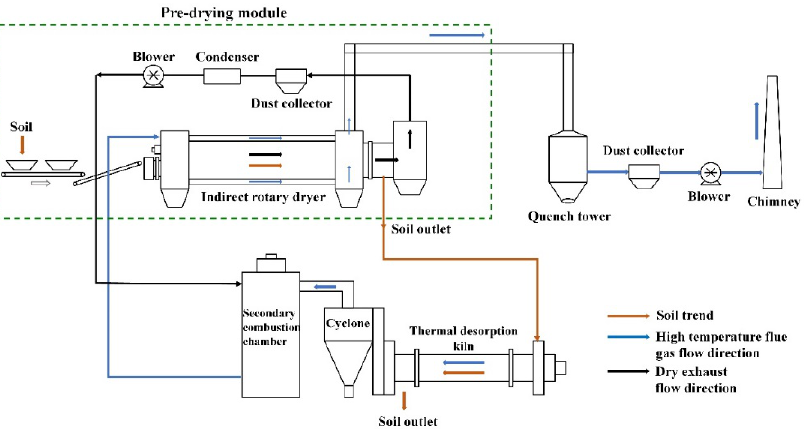
Figure 1. Direct thermal desorption system with pre-drying step to treat organic-contaminated soil. The key to efficient removal of water from soil lies in the design of the dryer and the drying characteristics. Rotary dryers are often used to dry agricultural products, such as grains and coffee [12], as well as industrial materials, such as cement and sludge [13], especially in the field of sludge drying. Most studies on rotary sludge drying have focused on two particular aspects: rotation speed and sludge moisture content.